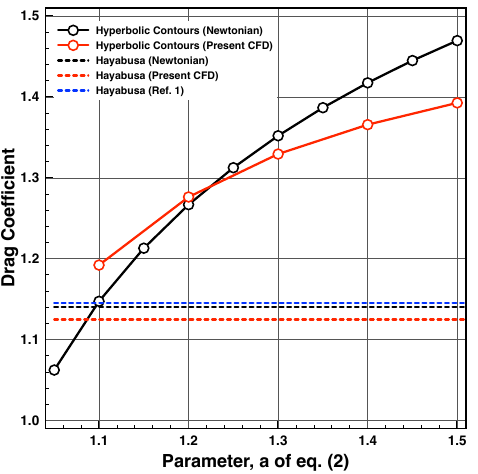
Figure 11. Effect of parameter of hyperbolic contours on the drag coefficients.